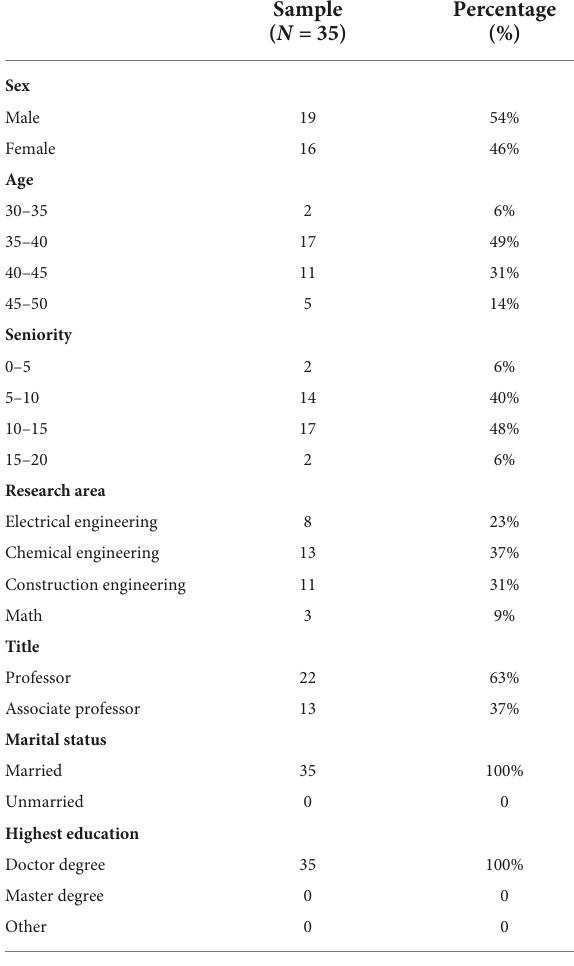
TABLE 1 Descriptive statistics of the